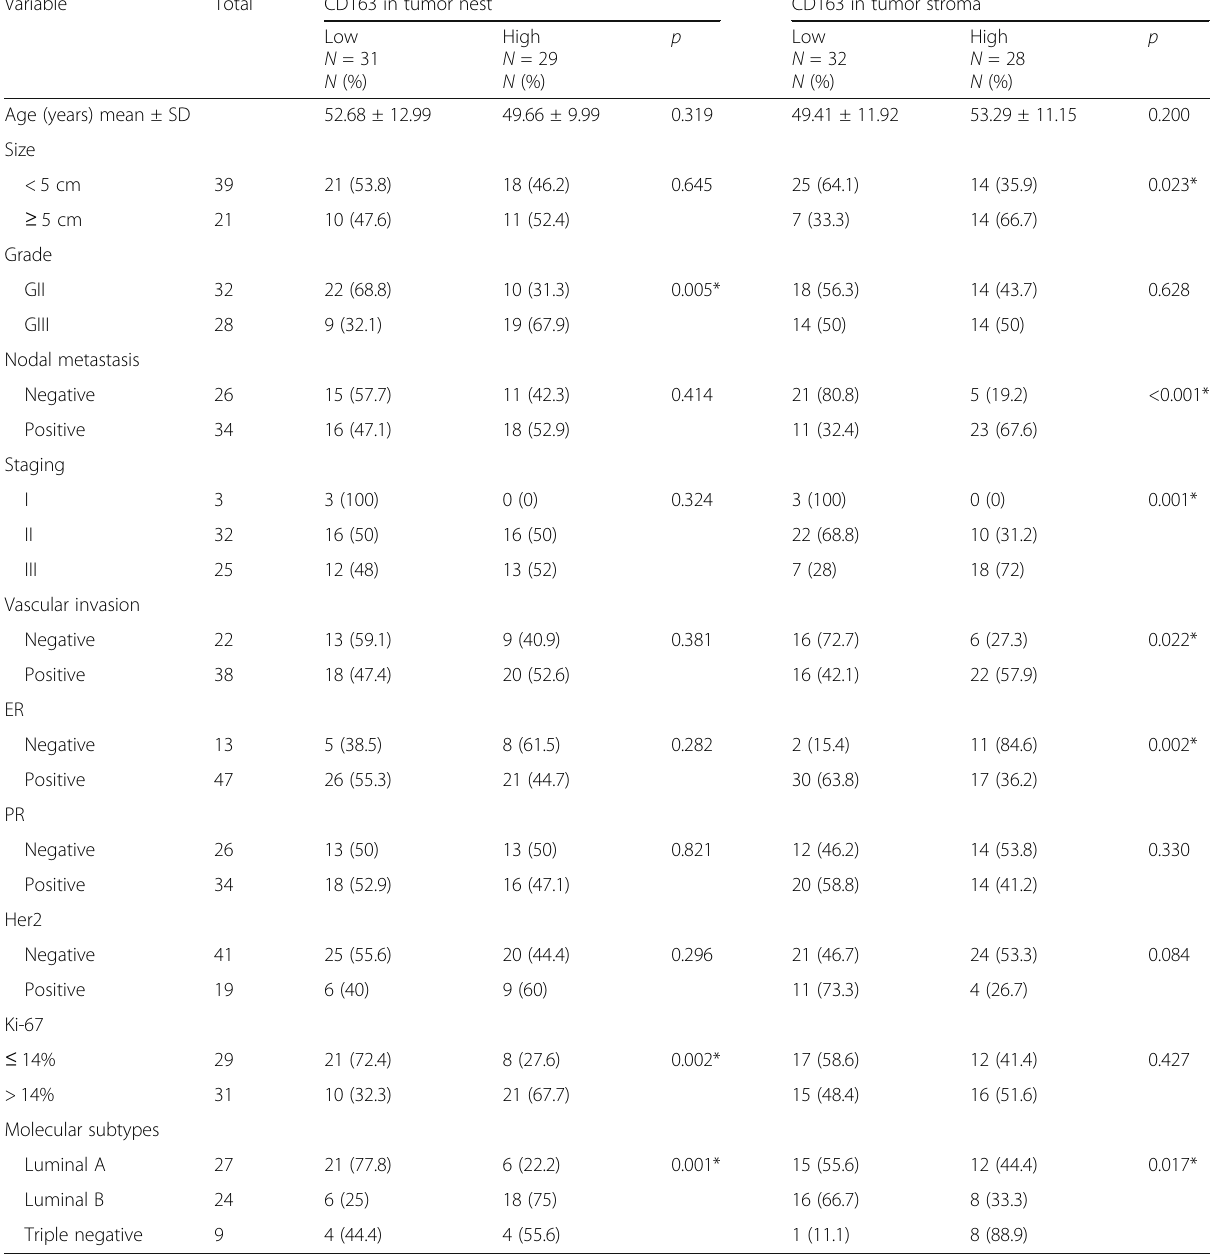
Table 5 Relation between CD163 expression in both tumor nest and stroma and clinicopathologic characteristics Variable Total CD163 in tumor